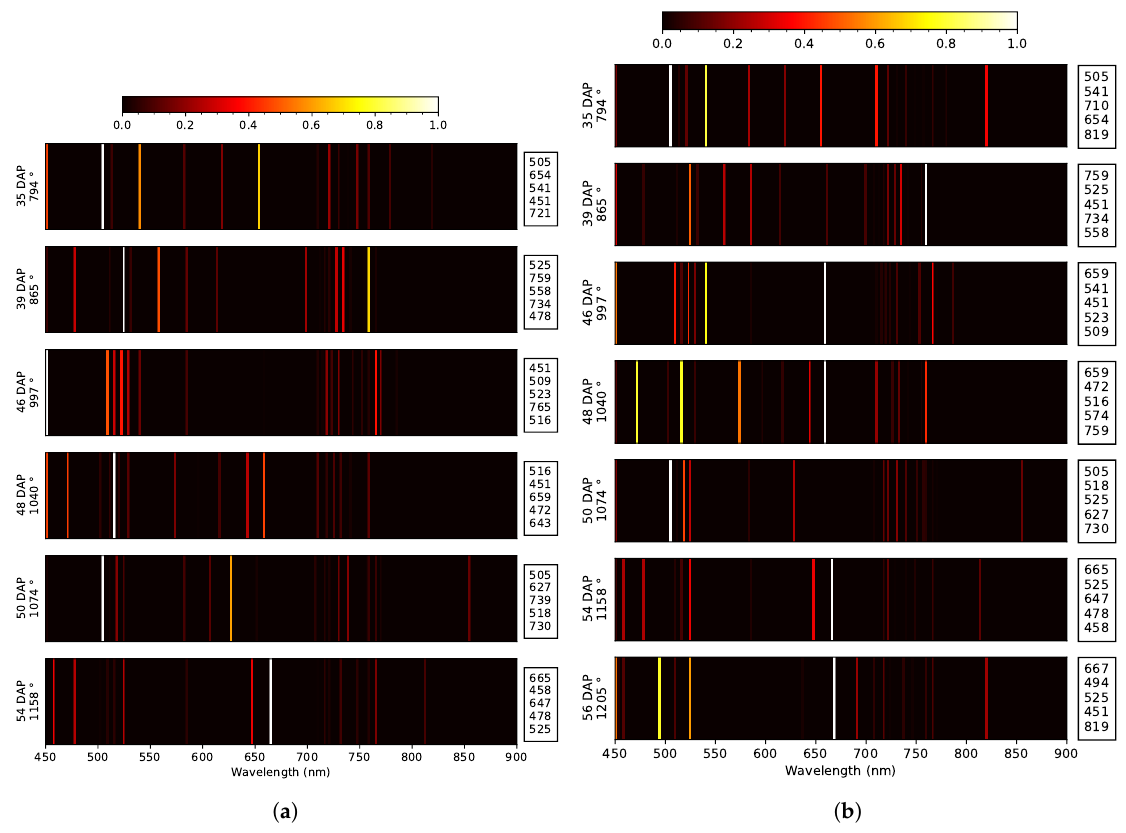
Figure 11. Snap bean pod weight 2019 data set average rankings at ( a ) the early harvest stage and ( b ) the late harvest stage, based on the SAM vegetation model. The corresponding days after planting (DAP) and heat unit for the collected data are shown to the left of each ranking belt, while the top five features, with the first one having the highest score, are listed to the